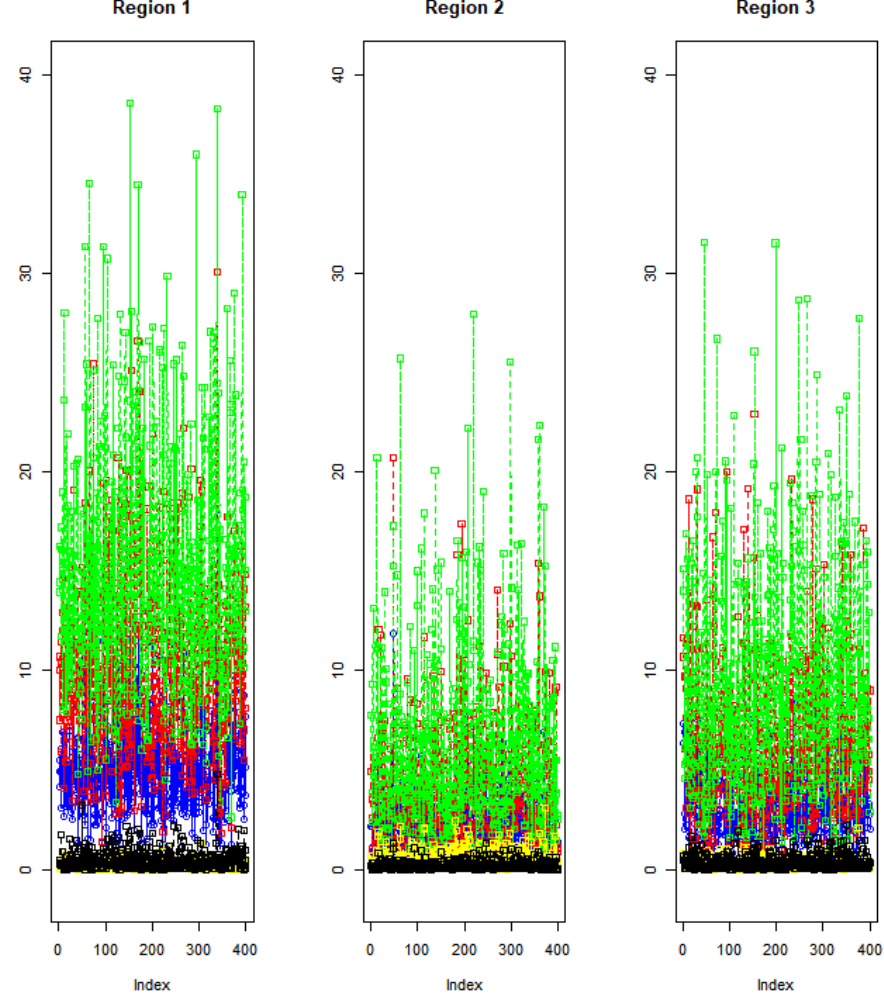
Figure 1. Plots with simulated multivariate data (region means